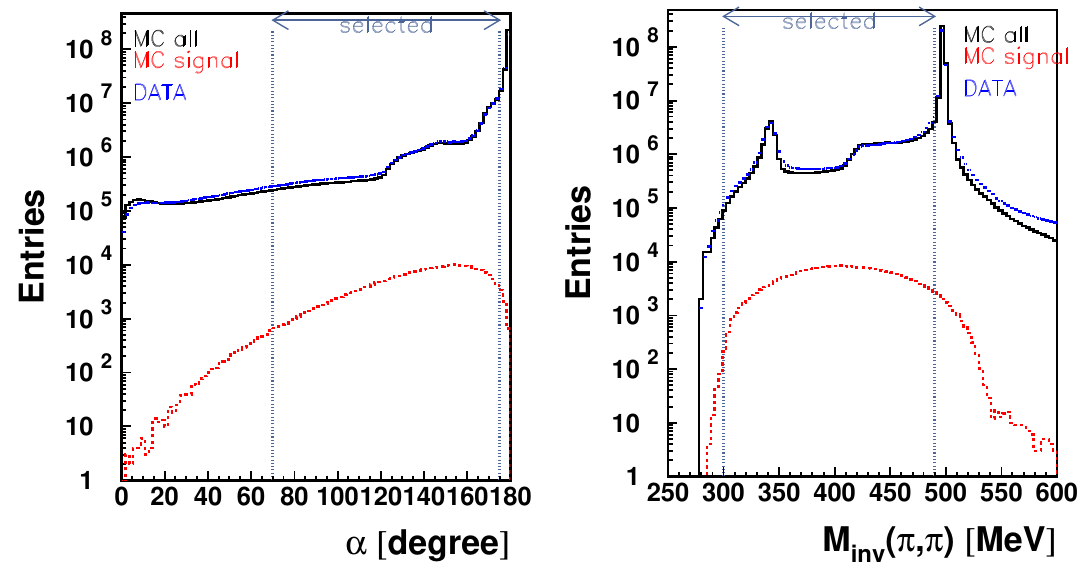
Figure 1 . Left: distribution of the (cid:11) angle between charged secondaries in K S rest frame. Right: distribution of the invariant mass M inv ( (cid:25); (cid:25) ) calculated under the assumption that both recon- structed tracks are pions. In both (cid:12)gures black solid lines represent all simulated events, the red dashed lines show simulated K S ! (cid:25)e(cid:23) signal events and blue points are data. Vertical dashed lines represent the cuts described in the